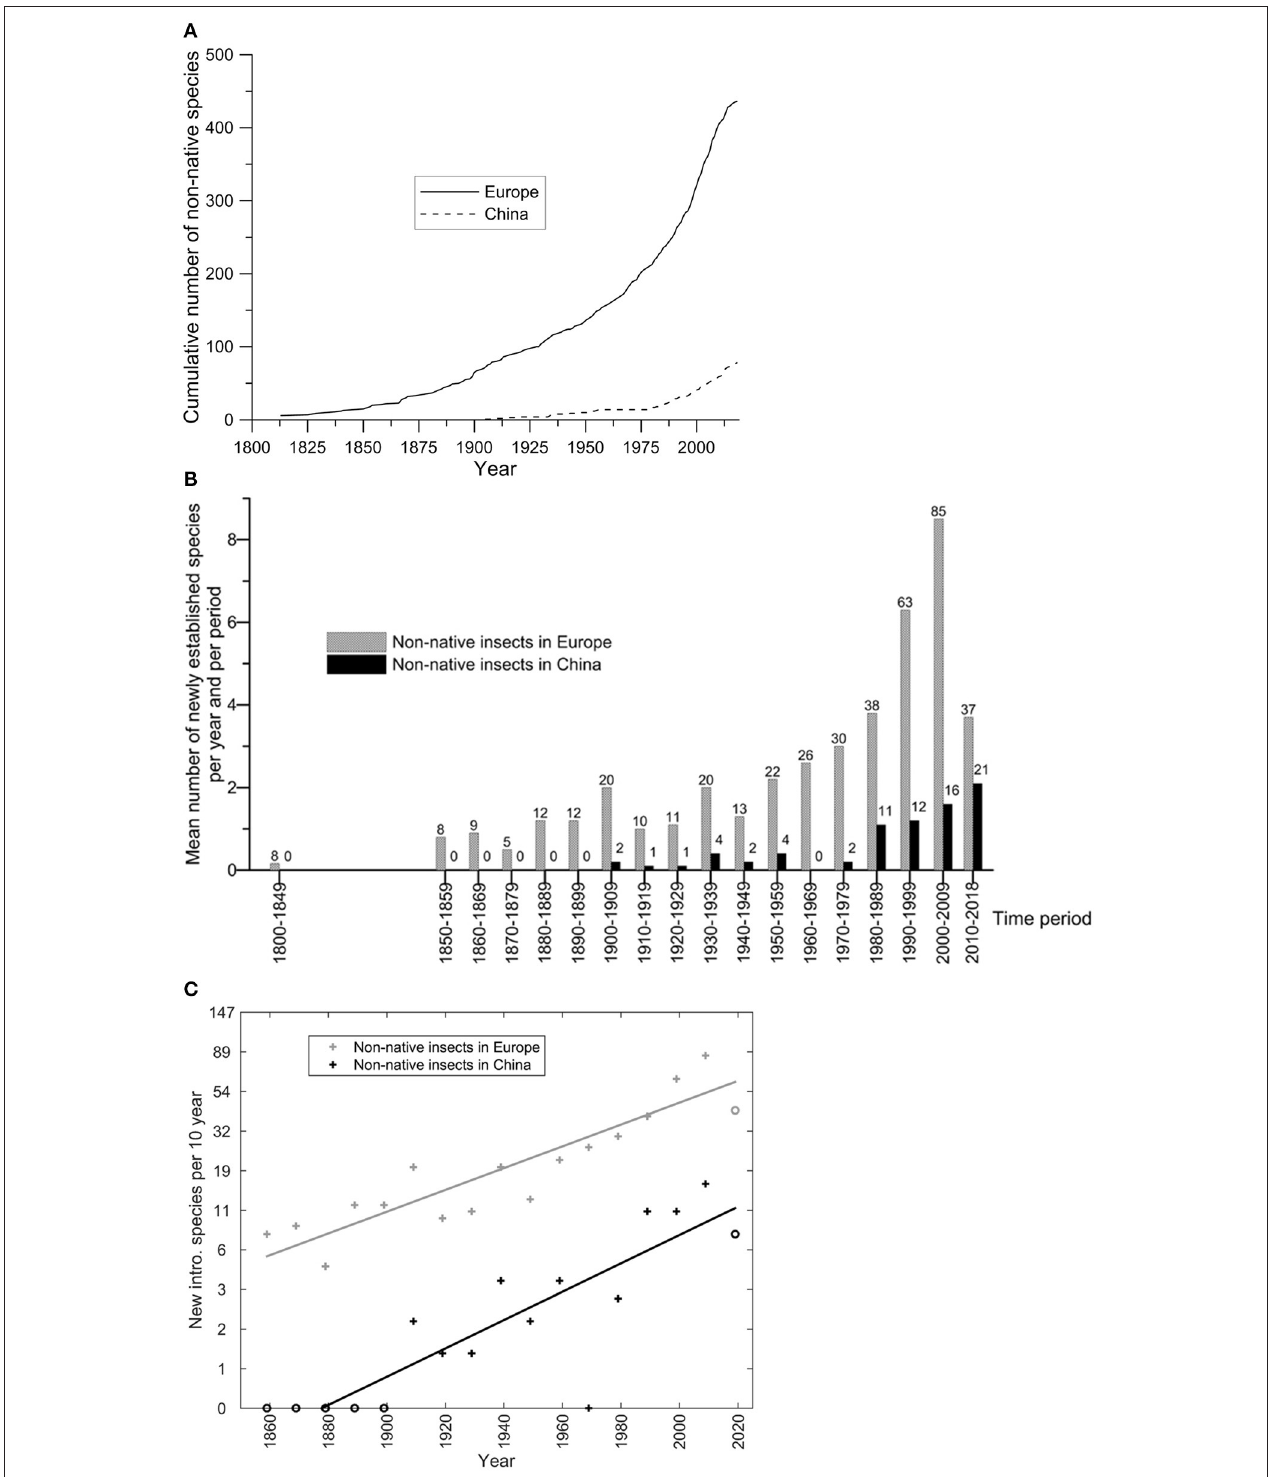
FIGURE 1 | (A) Cumulative number of detections (i.e., new establishments) of non-native insect species associated to woody plants over time in Europe and China; (B) Temporal changes in the mean number of new records per year of non-native species associated to woody plants having established in Europe and China up to 2019. The number above each bar indicates the total number of non-native species observed per 10-year period; (C) Fits of log-linear models log ( 1 + N ) = a t + b on the data shown in (B) . The circles correspond to the data that have not been taken into account during the fitting procedure. The y-axis is represented in log-scale, the linear trend thus indicating an exponential increase.